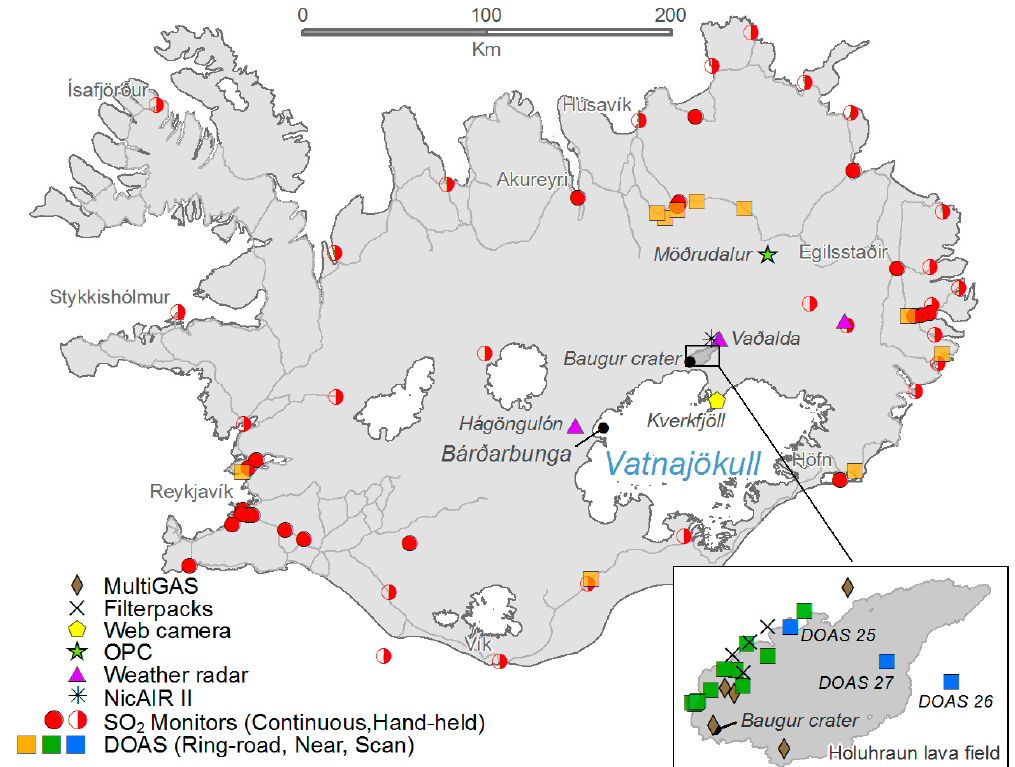
Figure 2. Map of Iceland showing the locations of the ground-based volcanic cloud monitoring instruments. An inset of the area around the eruption site is enlarged. The DOAS instruments are identified by number as described in the main text of this section. The ring-road DOAS traverses are marked at the location with the maximum SO 2 column amount. The near DOAS traverses are marked at the midpoint of the traverse.